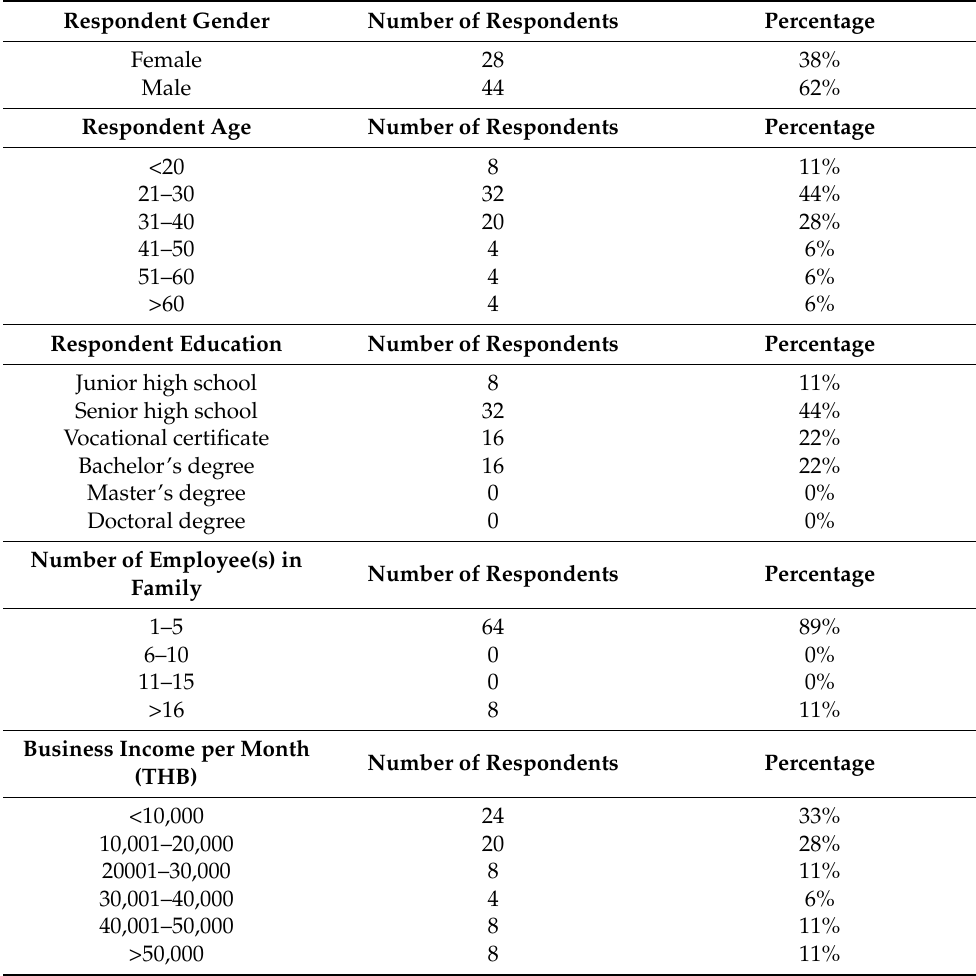
Table 2. Descriptive analysis of the